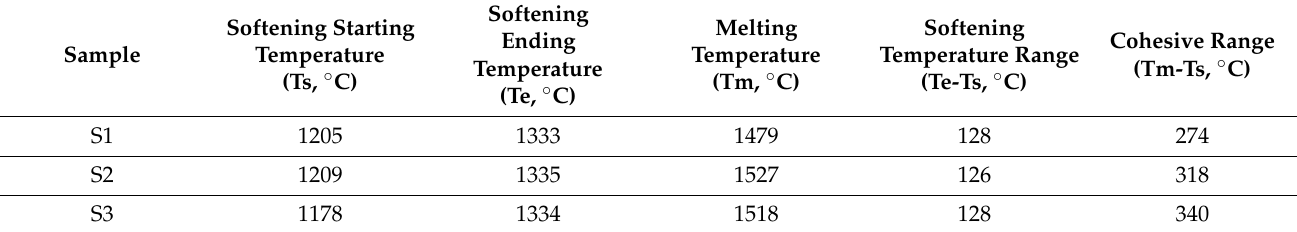
Table 5. Softening and melting temperatures of the sinters S1, S2, and S3 along with softening and cohesive